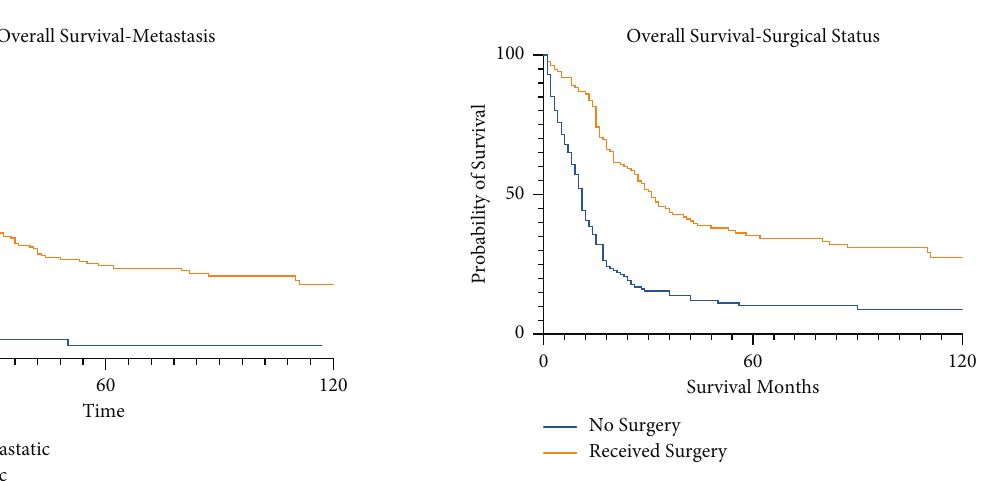
Figure 6: Kaplan–Meier survival curves for pelvic osteosarcoma patients by status of surgical intervention. Figure 5: Kaplan–Meier survival curves for pelvic osteosarcoma